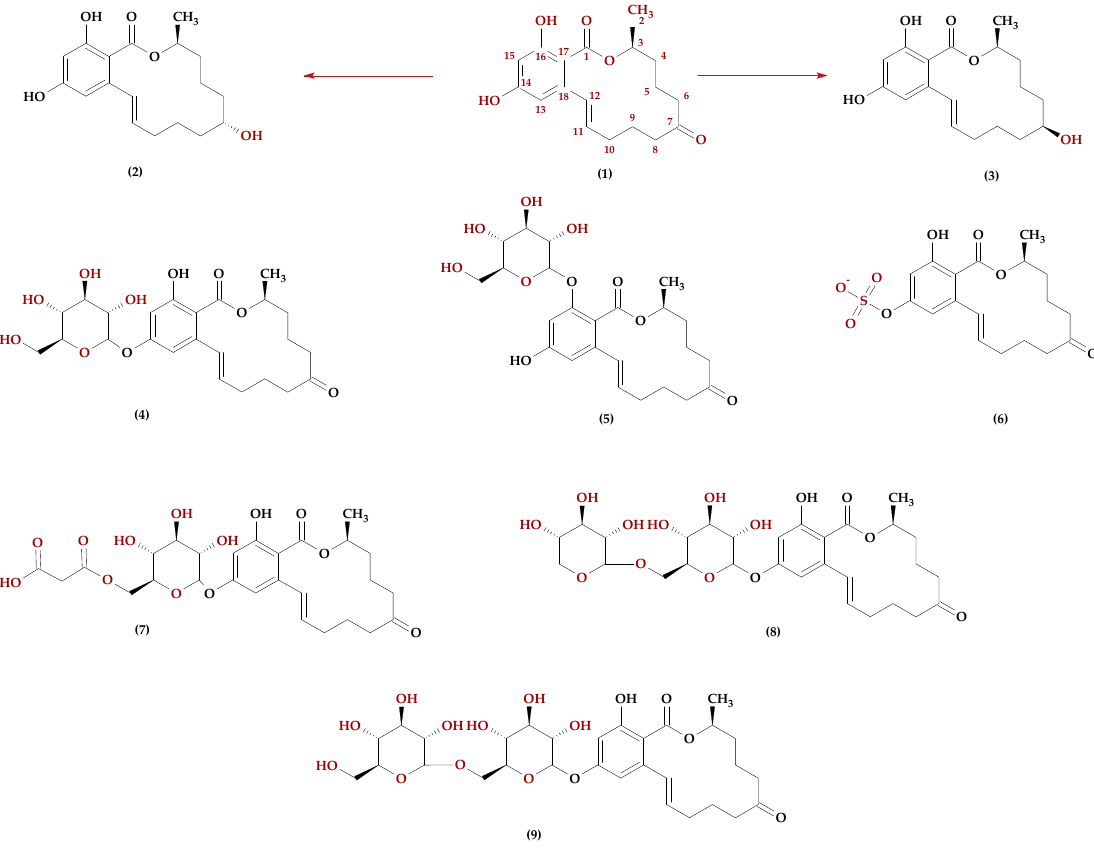
Figure 4. Chemical structure of some zearalenone derivatives: ( 1 ) α‐ ZEL, ( 2 ) ZEN, ( 3 ) β‐ ZEL, ( 4 ) ZEN ‐ 14Glc, ( 5 ) ZEN ‐ 16Glc, ( 6 ) ZEN ‐ 14S, ( 7 ) ZEN ‐ MalGlc, ( 8 ) ZEN ‐ 14GlcXyl, ( 9 ) ZEN ‐ 14diGlc.